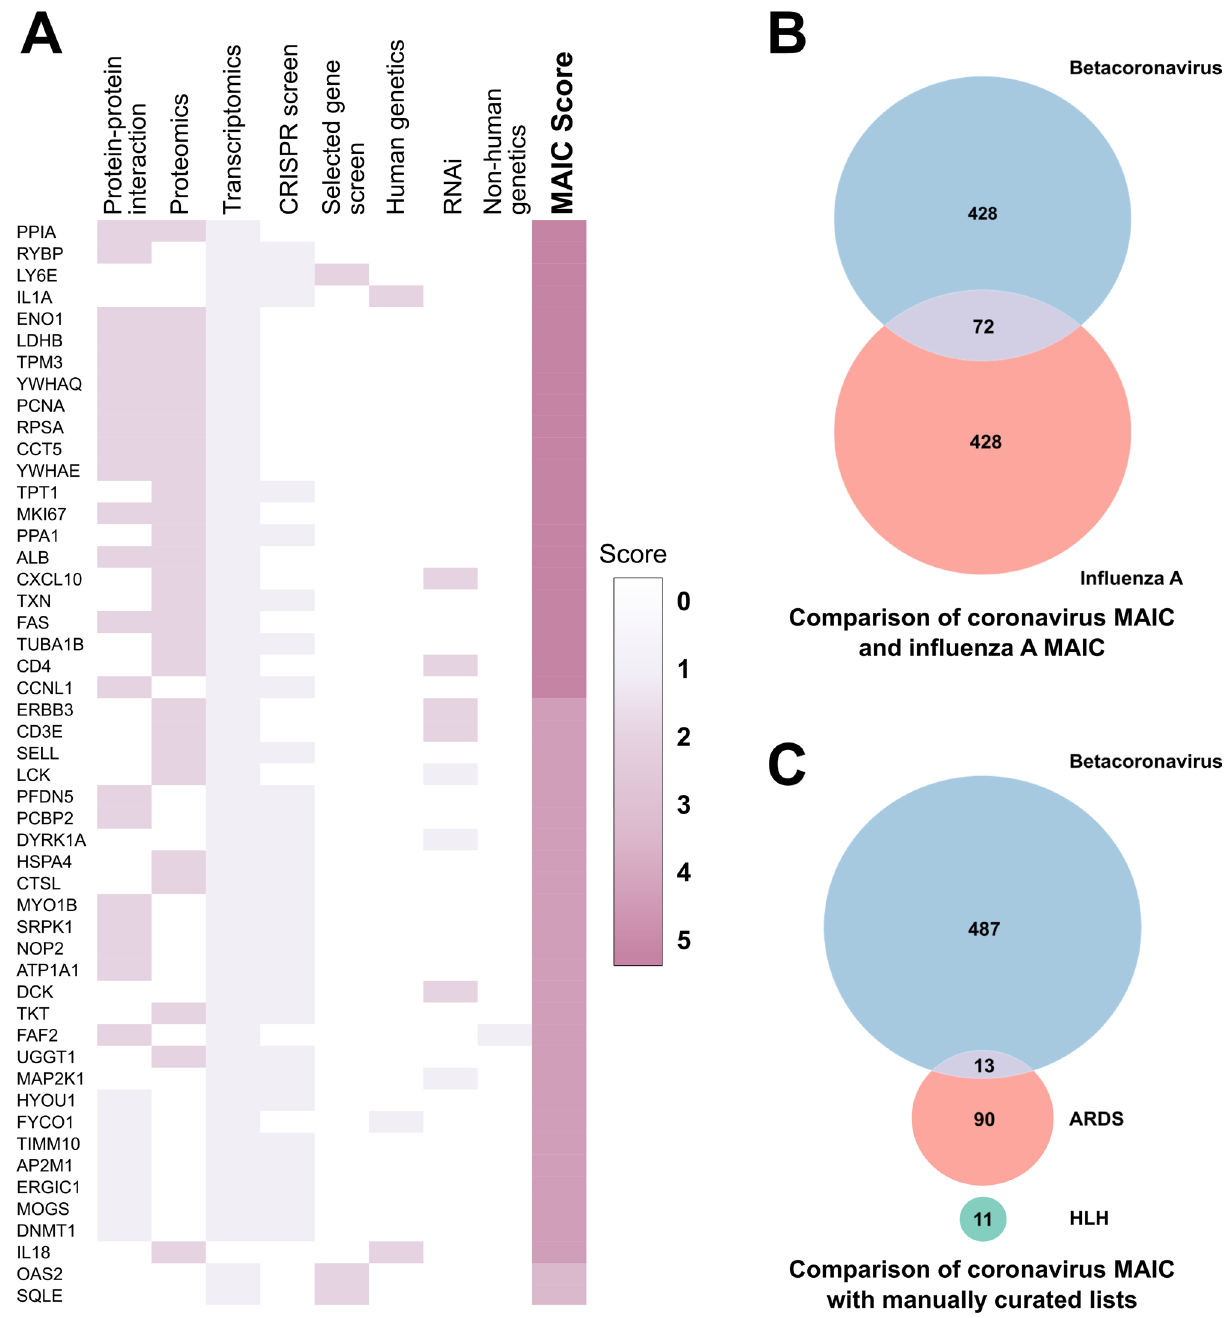
Figure 2. Highest ranked genes in the MAIC output and overlap with other conditions. ( A ) Heatmap of the top 50 genes implicated in SARS-CoV-2 infection, as ranked by the MAIC algorithm. The heatmap shows the information sources contributing to each of the top genes, by experimental category. Full details of all scored genes, including specific studies contributing to each, are given in Supplementary Table S1. ( B ) Venn diagram of overlap between the top 500 hits from this study and the top 500 hits from our previous MAIC analysis of Influenza A virus. ( C ) Venn diagram of overlap between the top 500 hits from this study and manually curated lists from available literature on HLH and